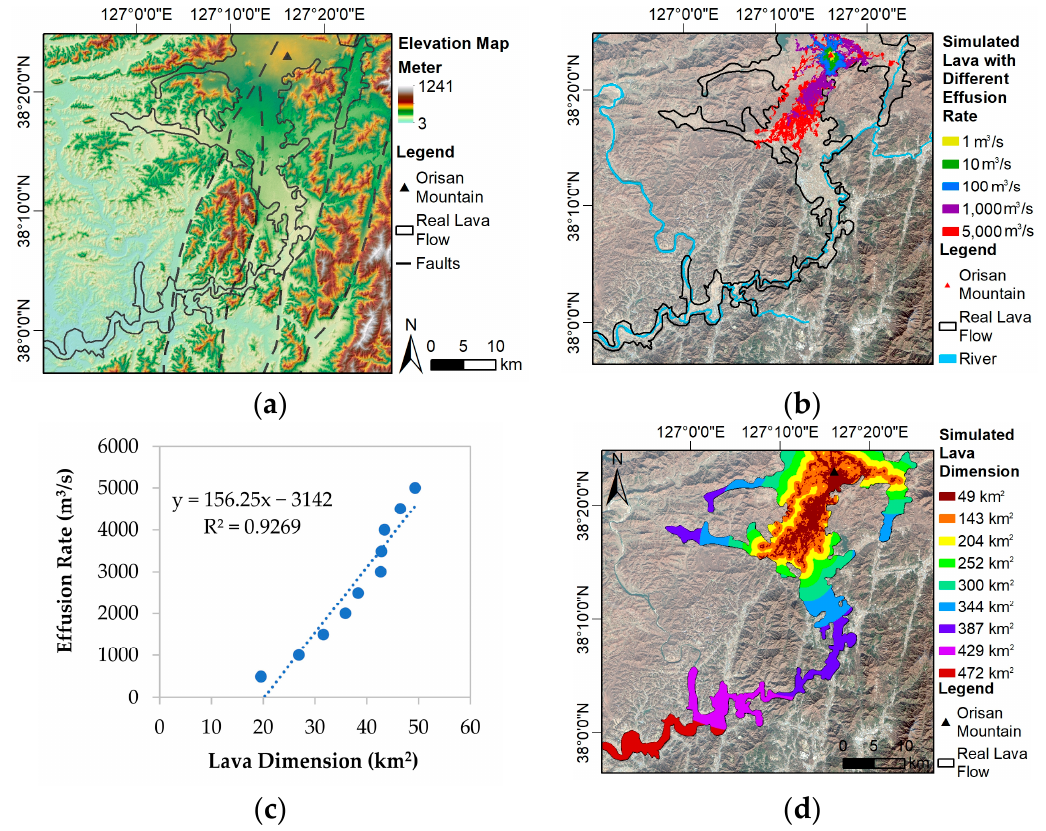
Figure 9. ( a ) Topographical map of the southern area of the Hantangang River Volcanic Field shown as an elevation map; ( b ) simulated lava flows with different effusion rates from Orisan Mountain; ( c ) relation between lava flow dimension and the lava effusion rate; ( d ) simulated lava dimensional flows.